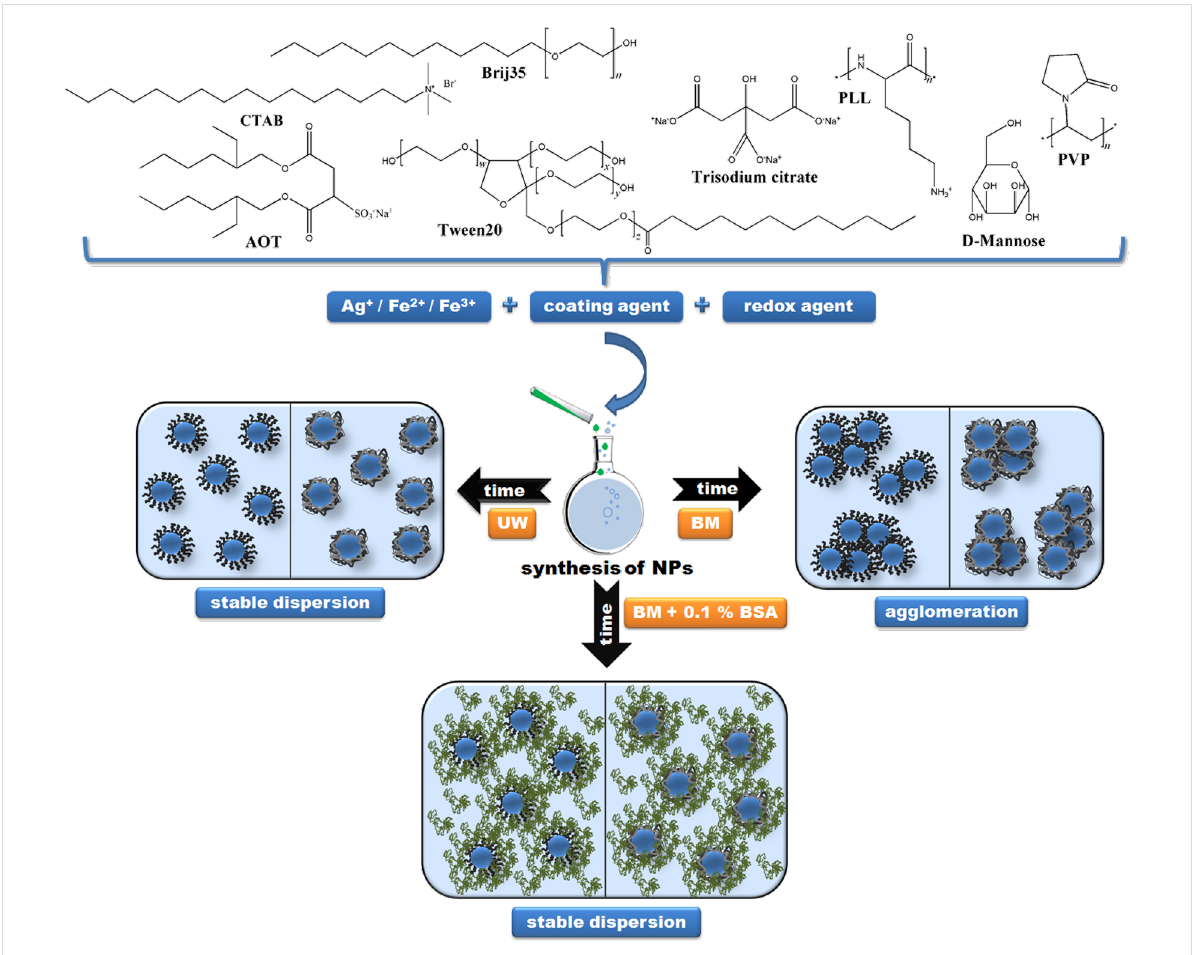
Figure 1: Experimental setup for stability evaluation of differently coated metallic nanoparticles in different media (UW - ultrapure water, BM - biologi- cal cell culture medium without addition of protein, BMP - BM supplemented with common serum protein).